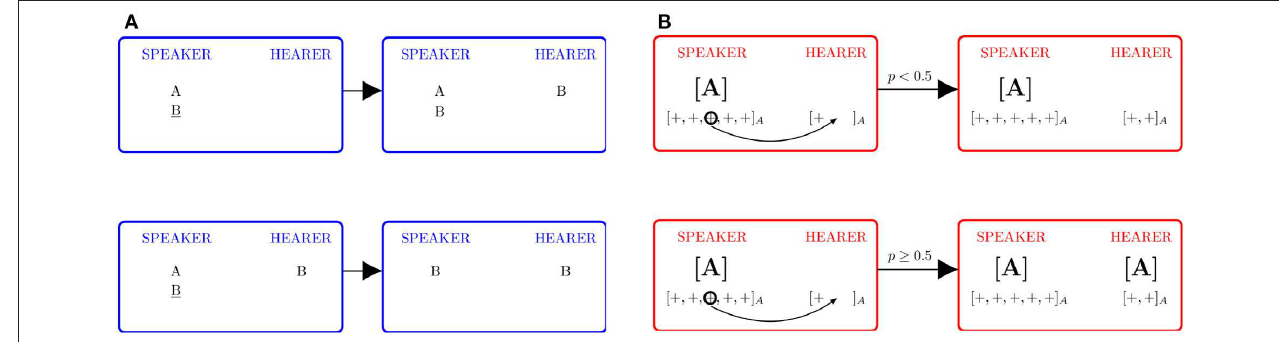
FIGURE 1 | Comparison of the basic and Bayesian NG models. (A) Basic two-conventions NG model. In a communication failure (upper figure), the name conveyed, B in the example, is not present in the list of the hearer, who adds it to the list. In a communication success (lower figure), the word B is already present in the hearer’s list, and both agents erase A from their lists. (B) Bayesian NG model. In order to convey an example “+” to the hearer in association with name A , the speaker must have already generalized concept C in association with A , represented here by the label [A]. In a communication failure (upper figure), the hearer computes the Bayes probability p , and the result is a p < 1 / 2; then, the only outcome is that the hearer records the example ( reinforcement ). In the Bayesian NG, there are two ways in which the communication can be successful. The first way (lower figure) is when p 1 / 2: the hearer generalizes C in association with A and attaches the label [ A ] to ≥ the inventory. The second way (not shown) is the agreement process, analogous to that of the basic NG, when both agents had already generalized concept C in association with name A and remove label [B] from their lists, if present. See text for further details.